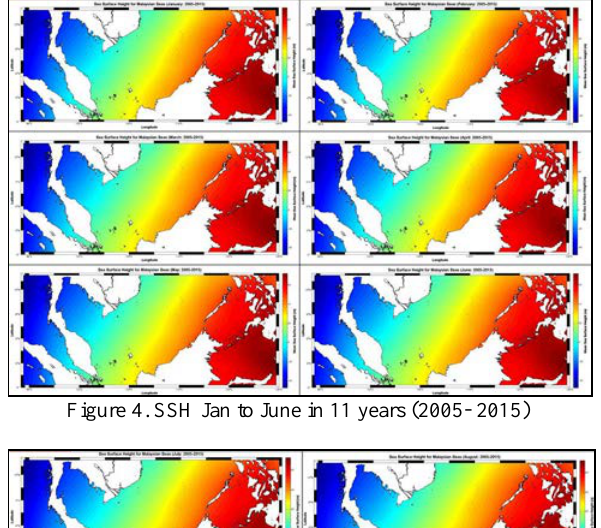
Figure 4. SSH Jan to June in 11 years (2005- 2015)